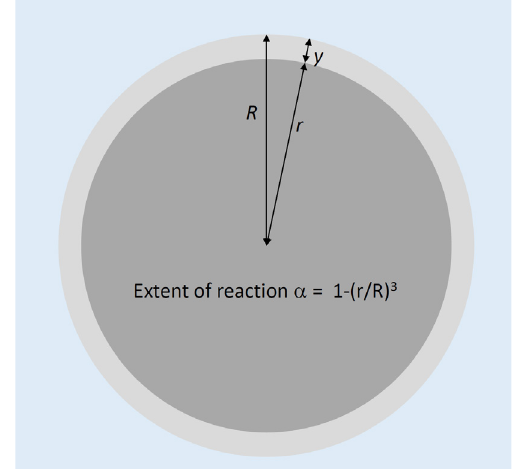
Figure 2. Definition of the extent of reaction ( α) for a spherical particle.